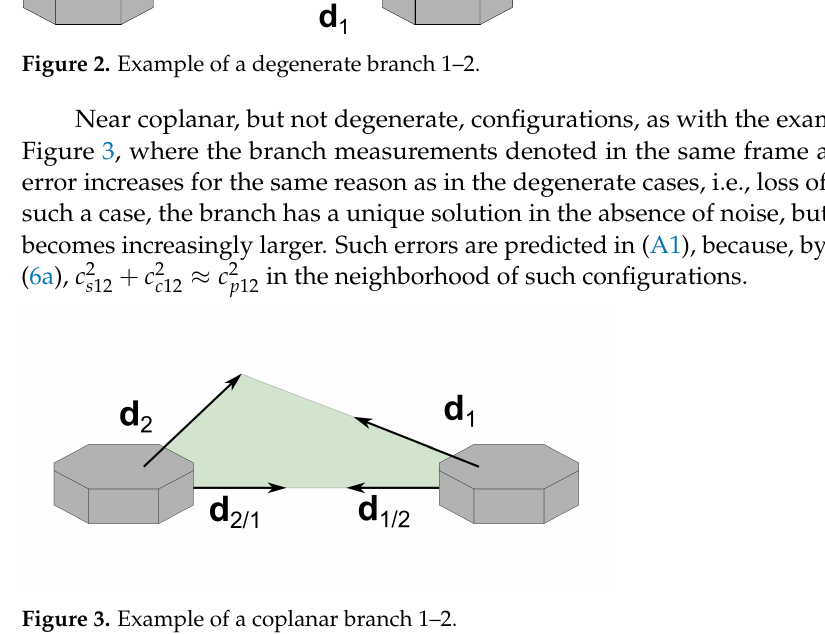
Figure 3. Example of a coplanar branch 1–2.